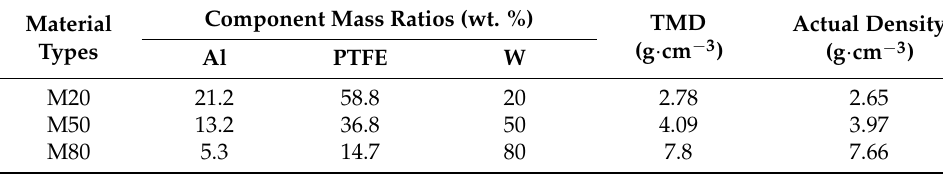
Figure 1. Schematics of specimens prepared: ( a ) quasi-static compression specimens, ( b ) dynamic compression specimens and ( c ) quasi-static tensile specimens. Table 1. Compositions and densities of the Al-PTFE-W reactive materials.